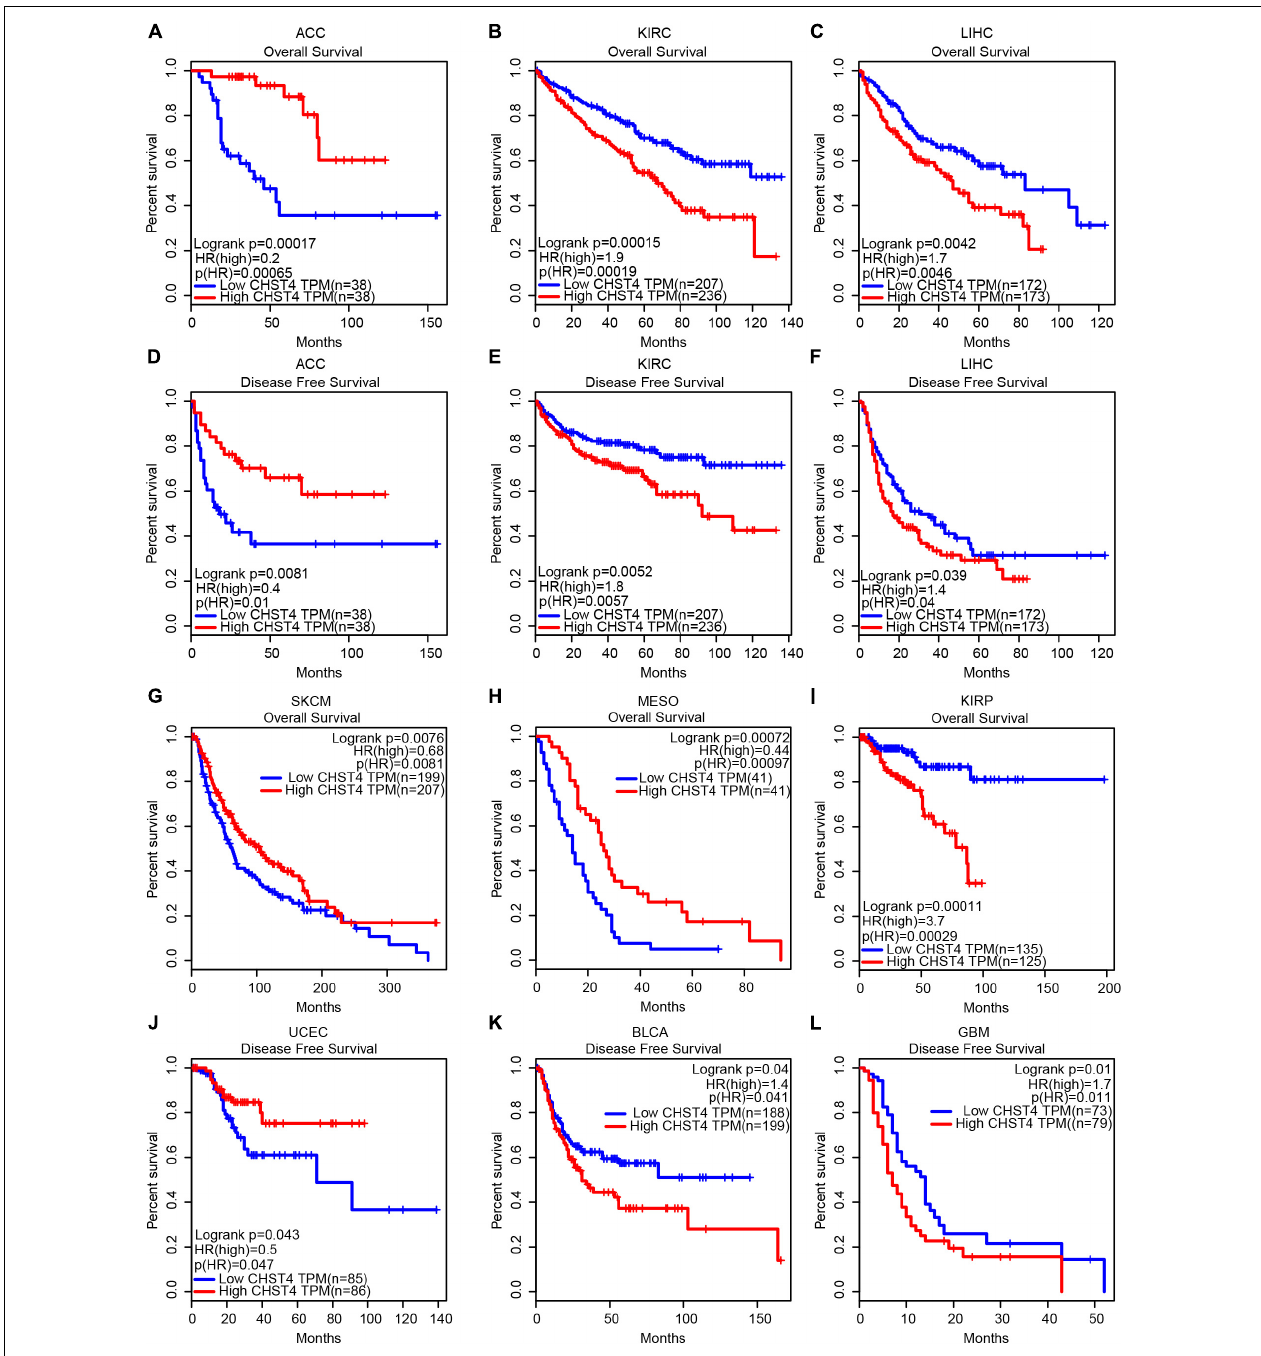
FIGURE 3 | The significance of CHST4 in the clinical prognosis of human tumors. (A–L) Kaplan–Meier analysis of the overall survival and disease-free survival in patients with ACC, adrenocortical carcinoma; KIRC, kidney renal clear cell carcinoma; LIHC, liver hepatocellular carcinoma; SKCM, skin cutaneous melanoma; MESO, mesothelioma; KIRP, kidney renal papillary cell carcinoma; UCEC, uterine corpus endometrial carcinoma; BLCA, bladder urothelial carcinoma, and GBM, glioblastoma multiforme using the GEPIA database. The division of CHST4 high and low expression is based on the median (50%) of CHST4 expression in each tumor